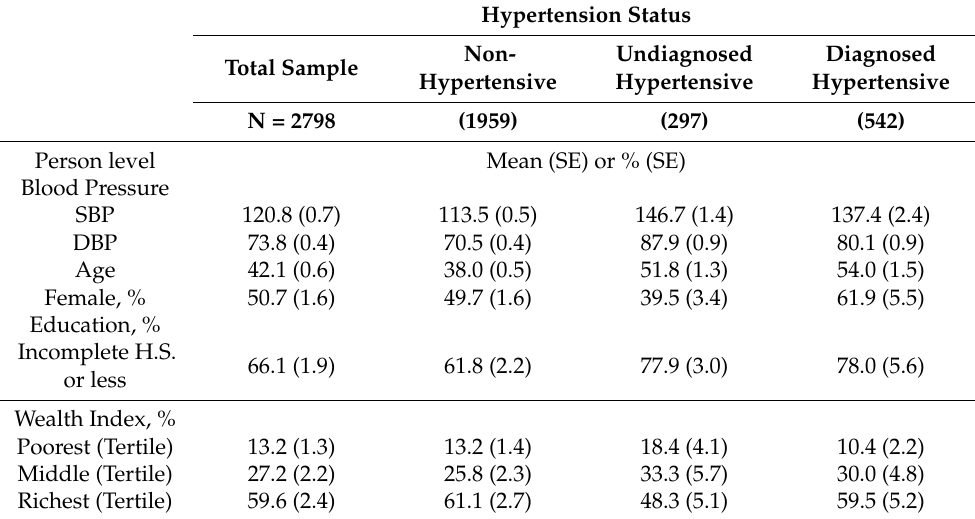
Table 1. Descriptive characteristics of adults with arterial blood pressure measurements (N =